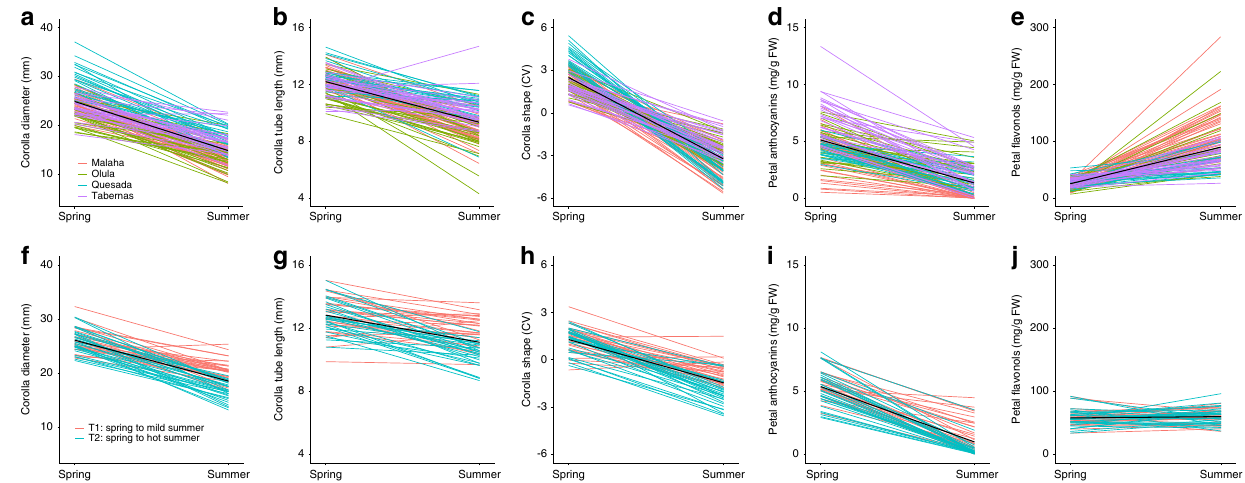
Fig. 3 Within-individual reaction norms of fl oral traits in fi eld and experimental conditions. The upper fi ve panels refer to fi eld conditions, pooling the individuals of the four studied populations ( n = 117 individuals). The lower fi ve panels refer to experimental conditions, pooling individuals of the two treatments ( n = 58 individuals). a , f Corolla diameter, in mm. b , g Corolla tube length, in mm. c , h Corolla shape, as the value of the CV component of a landmark-base geometric morphometric analysis. d , i Anthocyanin concentration in corolla, expressed as cyanidin-3-glucoside equivalents per fresh weight. e , j UV-absorbing fl avonols concentration in corolla, expressed kaempferol-3-glucoside equivalents per fresh